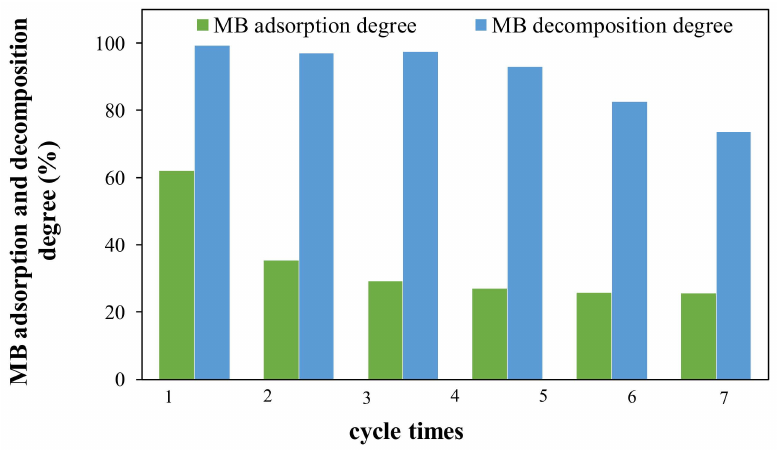
Figure 11. Cycling stability of adsorption and decomposition of methylene blue for the TiO 2 /rGO-8- 700 sample under UV